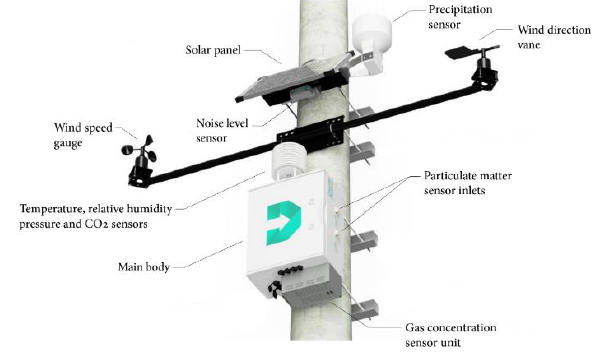
Figure 2 . Air quality station in "summer" configuration.